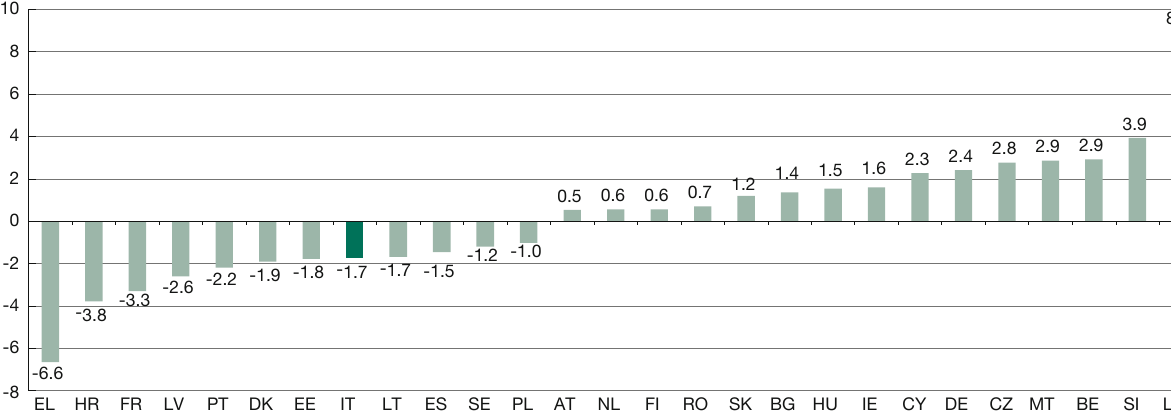
Source: European Commission (2018), The 2018 Ageing Report: Economic and Budgetary Projections for the EU Member States ,